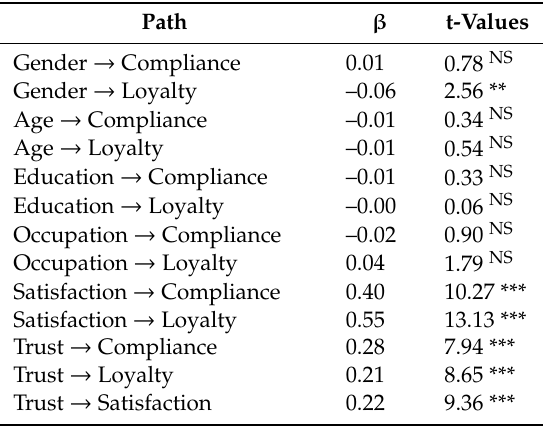
Table 6. Results regarding direct e ff